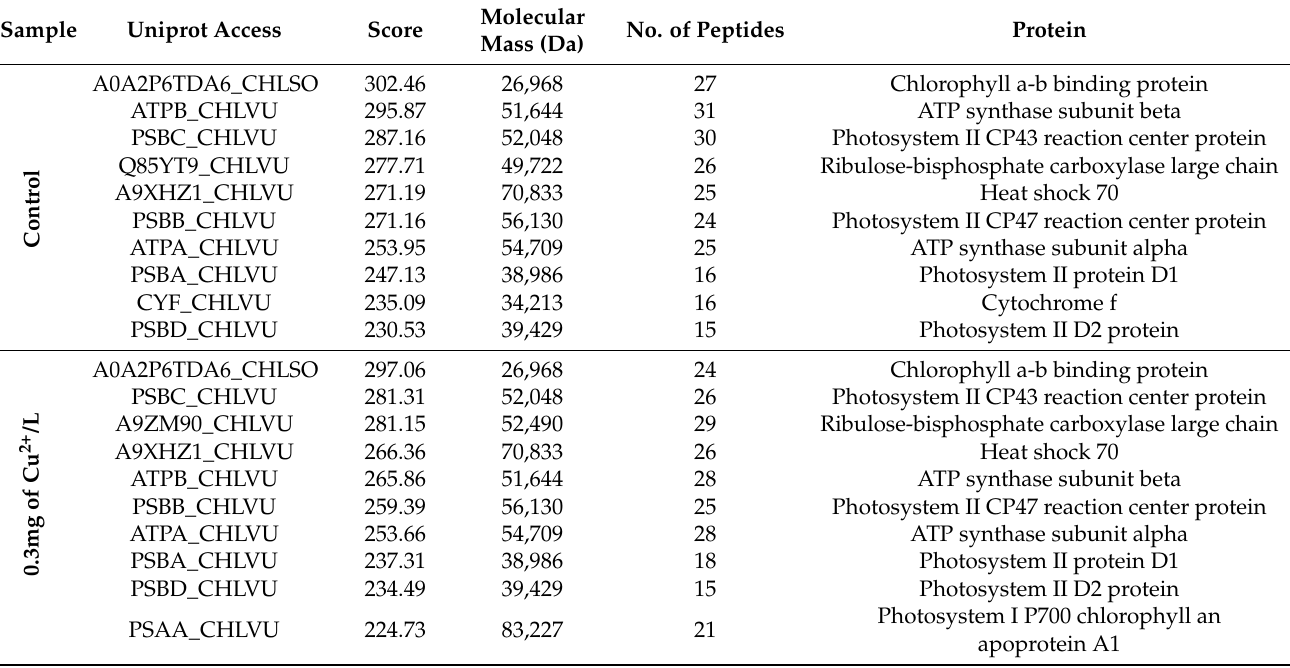
Table 1. Identified proteins according to the ten highest scores for control and Cu 2+ treatments.